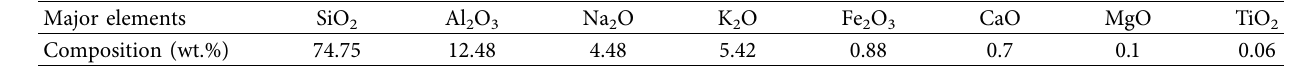
Table 1: Quantitative chemical composition of perlite